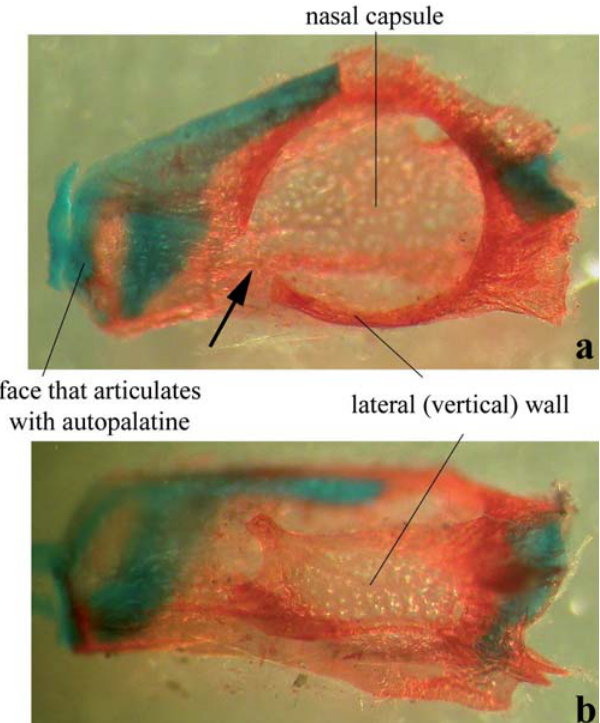
Fig. 17. Dorsal (a) and lateral (b) views of the lateral ethmoid of Pterosturisoma microps (MZUSP 79909, 75.9 mm SL). Arrow points to anterior portion of lateral ethmoid that lacks an ossified